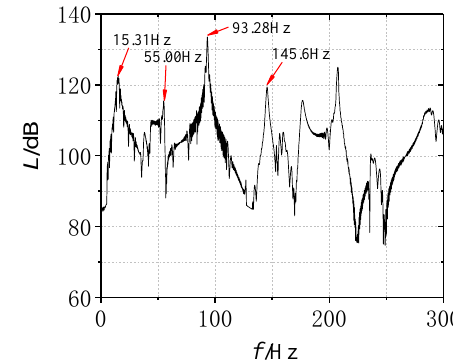
Figure 10. Vibration response of rigid pipeline.